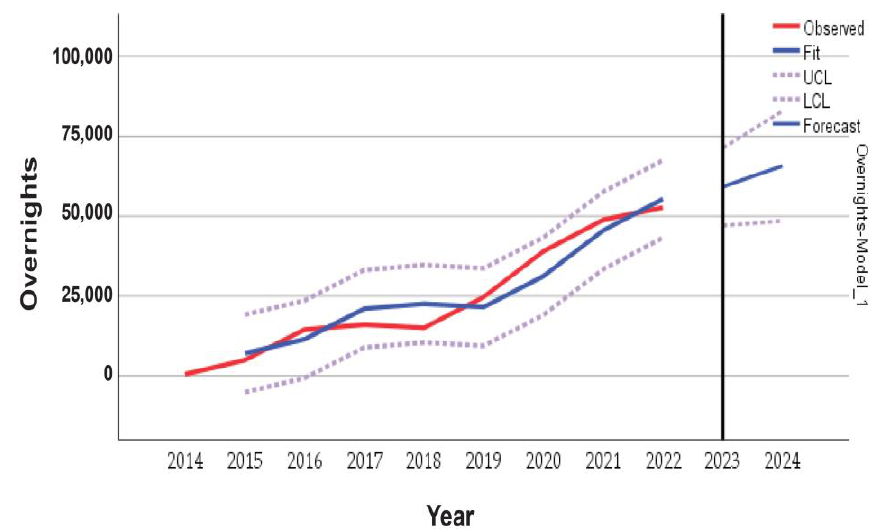
Figure 11. Residual ACF and PACF.